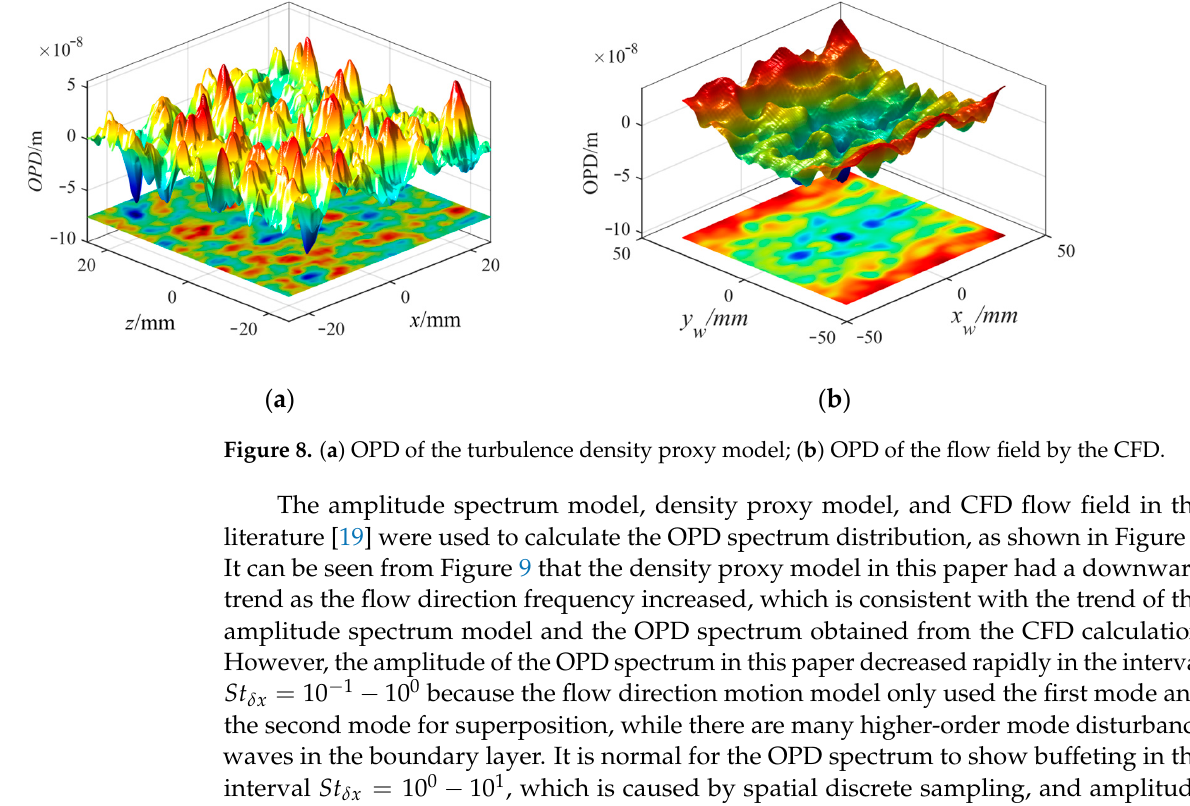
( d ) Figure 10. Monte Carlo verification results under different conditions: ( a ) distribution of sampling points at 10 km; ( b ) relative error of OPD at 10 km; ( c ) distribution of sampling points at 15 km; ( d ) relative error of OPD at 15 km.